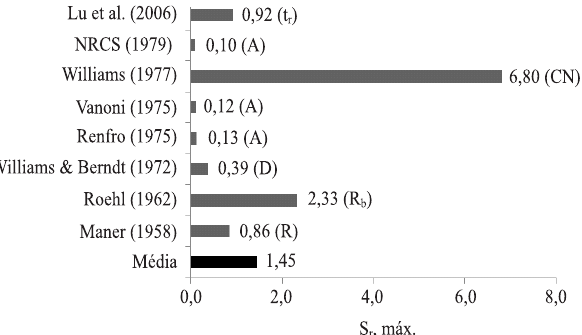
Figura 6. Sensibilidade relativa máxima das equações de RAS às suas variáveis, indicando a variável responsável (ver descrição das variáveis no Quadro